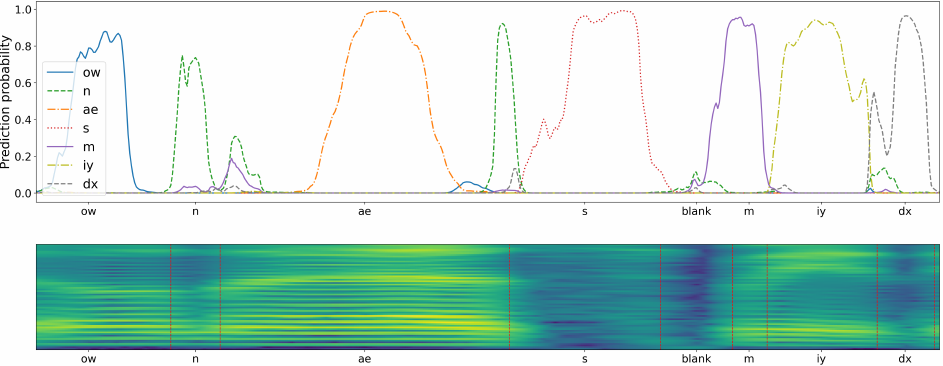
Figure 8. Probabilities produced at seven CNN-classifier outputs ( top ) during analysis of Mel- Spectrogram composed of seven different phonemes ( bottom ), for a classifier trained on central phoneme examples. Observe an erroneous detection of a consonant ‘n’ in the middle part of the